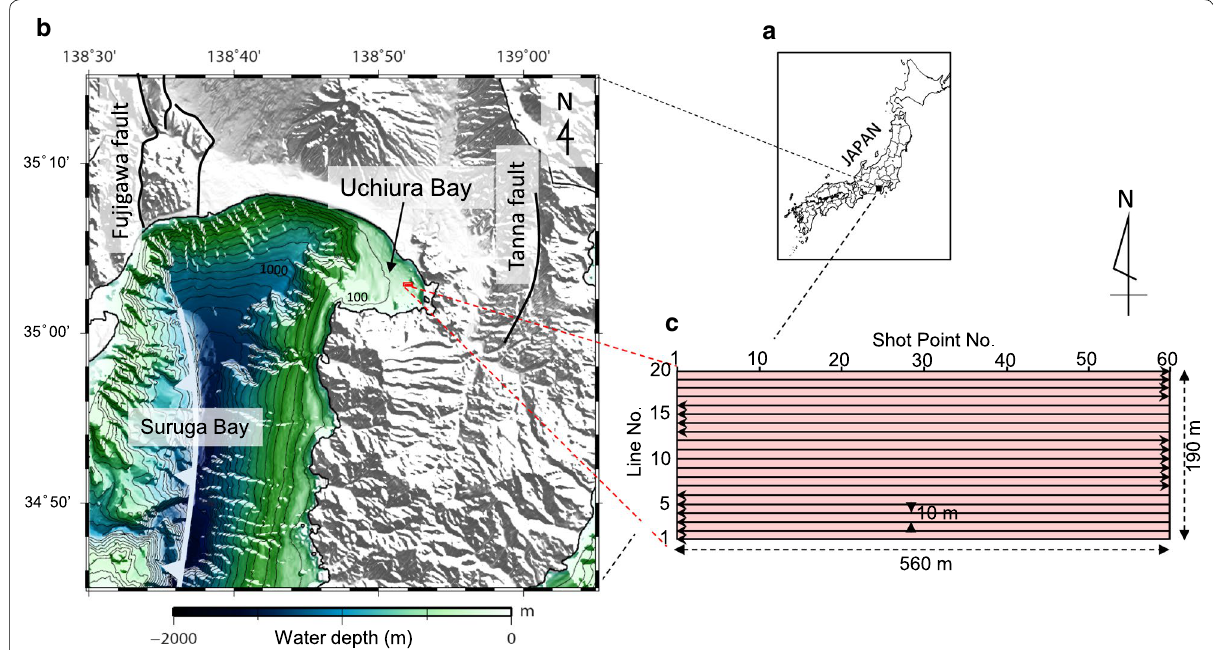
Fig. 1 a Index map. b The study area, Uchiura Bay, is located on the inner part of Suruga Bay. Two major active faults of the strike–slip type run on both sides of the study area. c A total of 20 seismic lines were deployed in a dense‑2D survey area of 560 the boat’s